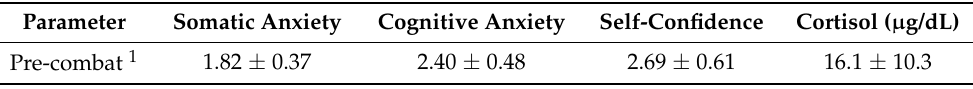
Table 1. CSAI scores and cortisol determination in plasma of novice jiu-jitsu athletes before an official competition (N = 13).